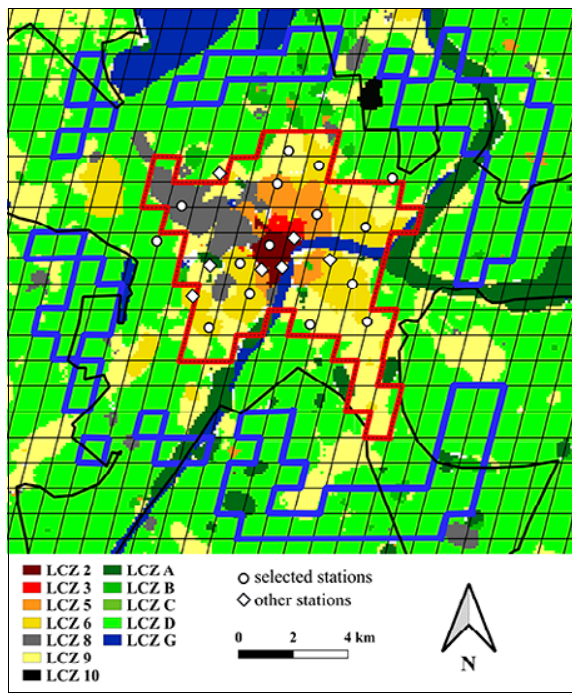
Figure 2. LCZ map shown on the MODIS grid covering the study area with administrative city border (black line), delineated urban (red line) and rural (blue line) polygons in and around Szeged (the elements of the 24-station network are marked by circles and